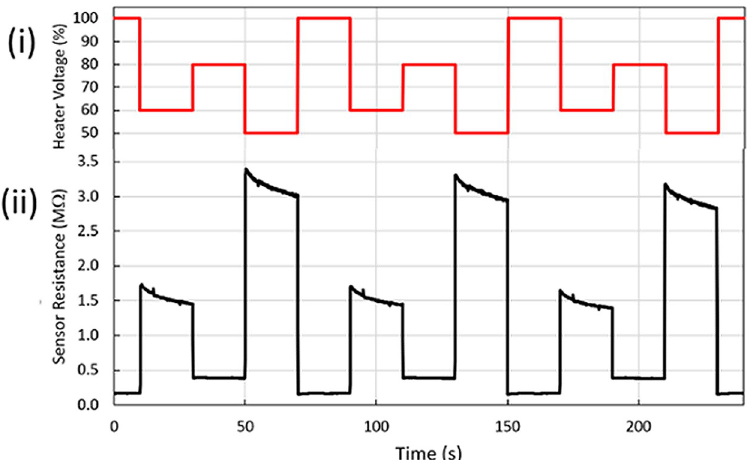
Fig 2. Example of a temperature profile modulation for MOX sensors for IBM EVA ™ : (i) periodic waveform of heater voltage, expressed as a percentage of the maximum operating voltage recommended by the sensor manufacturer; (ii) corresponding variations in MOX sensor resistance under constant